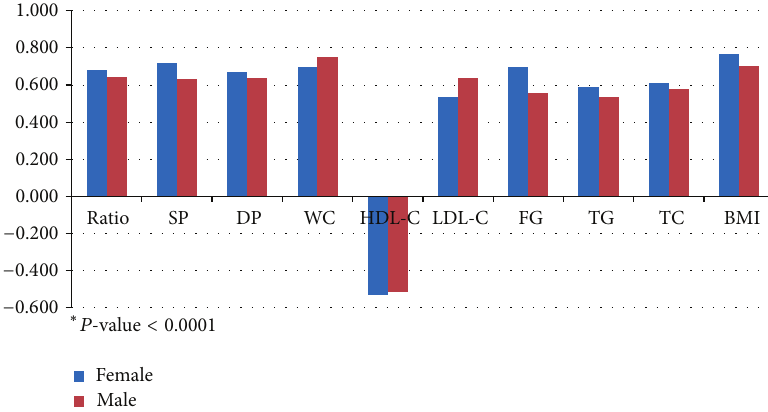
Figure 1: Spearman partial correlation ( 𝑟 ) analysis of HOMA2-IR with ApoB/ApoA-I ratio, MetS components, BMI (body mass index), TC, and LDL-C in men and women (controlling by age). Partial correlation: Spearman partial correlation coefficient 𝑟 ; 𝑃 (2-tailed) < .0001. ApoB/ApoA-I ratio: apolipoprotein B/apolipoprotein A-I ratio, SP: systolic blood pressure, DP: diastolic blood pressure, WC: waist circumference, BMI: body mass index, HDL-C: high-density lipoprotein cholesterol, LDL-C: low-density lipoprotein cholesterol, FG: fasting glucose, TG: triglyceride, TC: total cholesterol, and HOMA2-IR: homeostasis model assessment of insulin